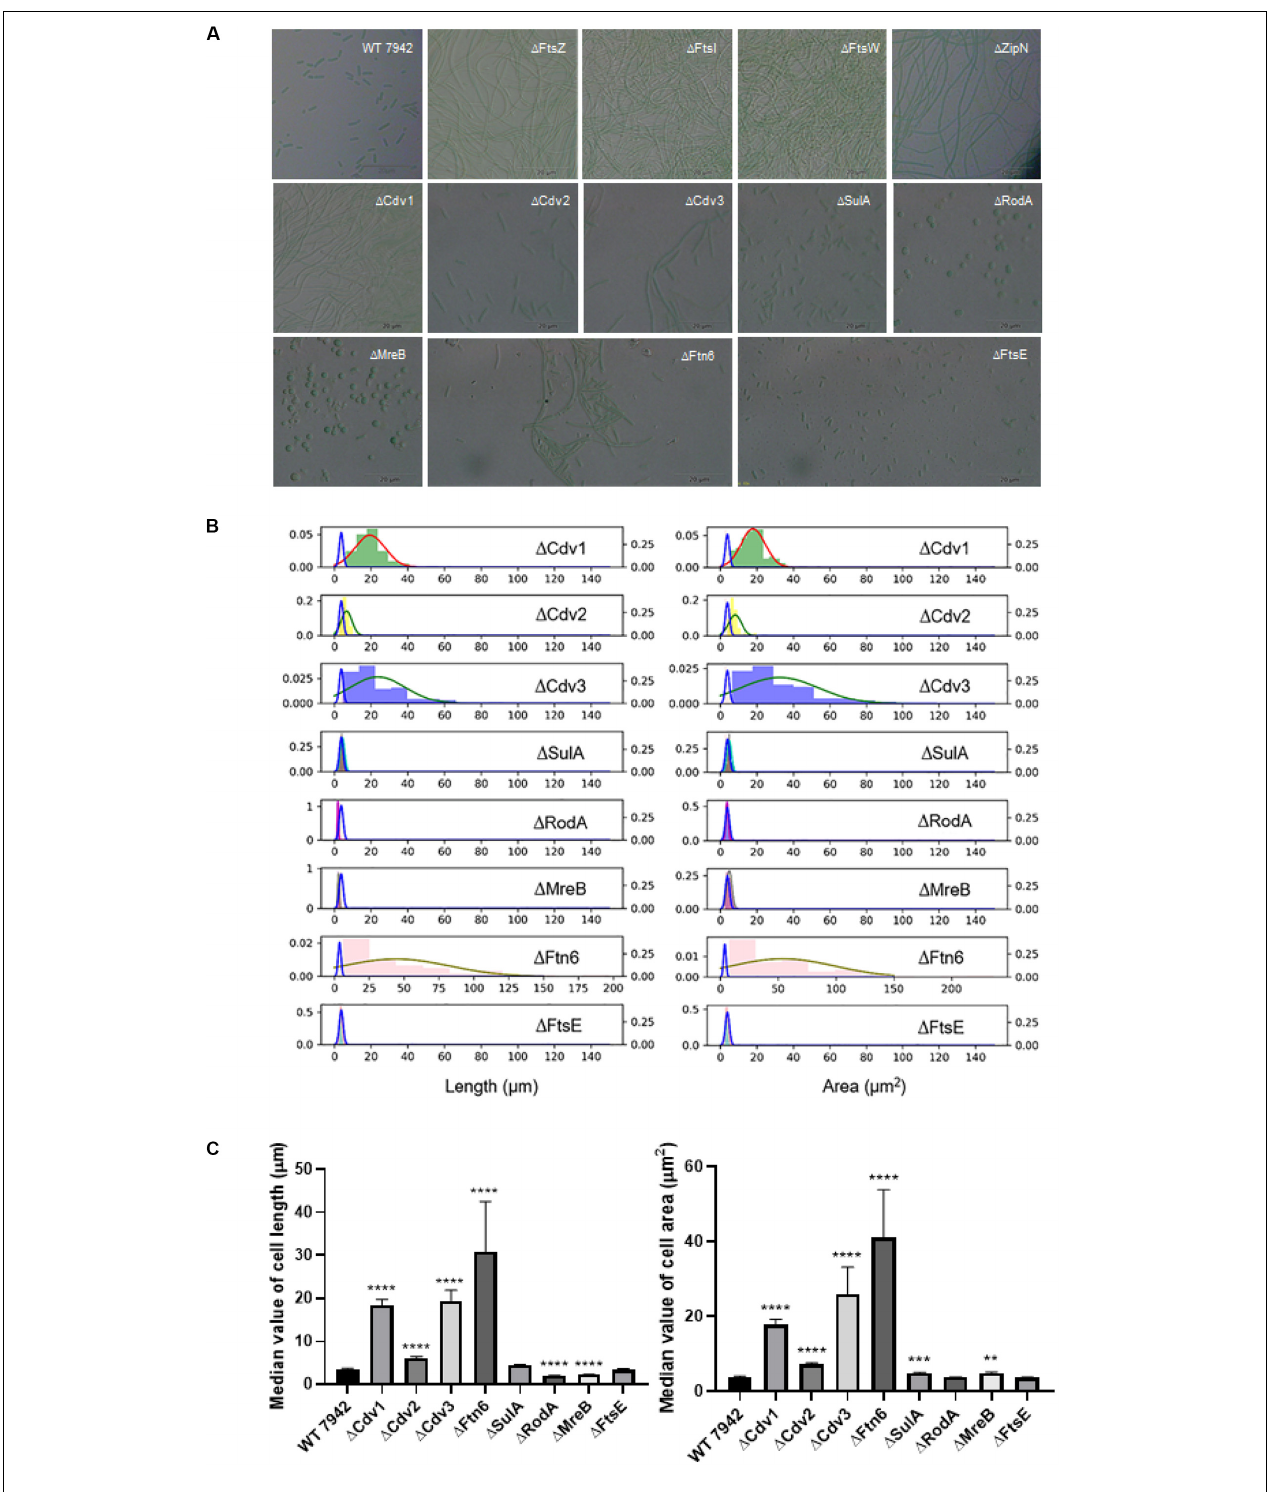
FIGURE 2 | The disruption effects of the candidate genes on cellular morphology of PCC7942. (A) Microscopic photo of the wild type PCC7942 and disruption mutants. (B) The distribution histogram and normal distribution curve of the cell length (left) and the cell area (right) in the mutant strains compared with the wild-type strain (blue line). At least 100 cells were evaluated for statistical analysis. The left and right Y axes represent the distribution probability of the mutants and the wild type, respectively. (C) The comparison of cell length (left) and cell area (right) between wild type and mutant strains based on the value of median with 95% CI. The Kruskal-Wallis test in One-way ANOVA was used to analyze the significant difference. * indicates < 0.05; ** indicates < 0.01; *** indicates < 0.001; **** indicates < 0.0001.